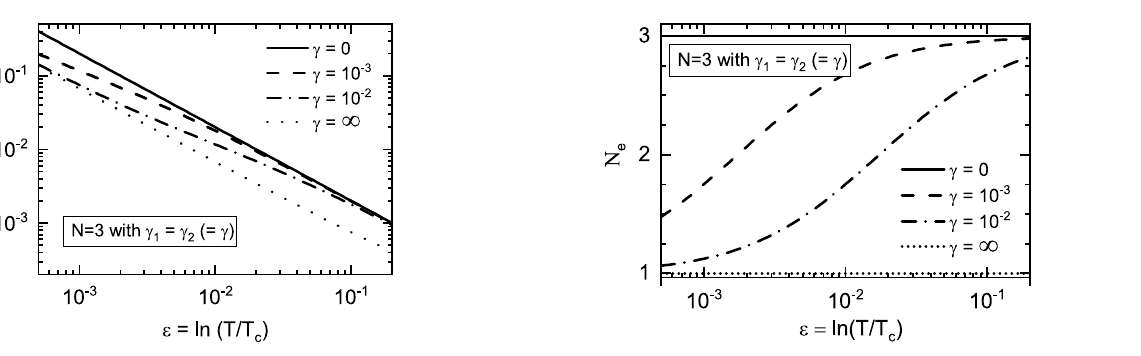
Fig. 9 Effective number of independent fluctuating planes, N e , for three-layer superconductors with a single Josephson coupling, 𝛾 = 𝛾 1 = 𝛾 2 , as a function of 𝜀 and for different 𝛾 . The figure illus- trates crossovers between the N e = 1 and 3 values (with no plateau at N e ≃ 2 ) as 𝜀 and 𝛾 vary (and with them the corresponding inter- plane correlations) correlated with the evolutions of the critical exponent x in Fig.